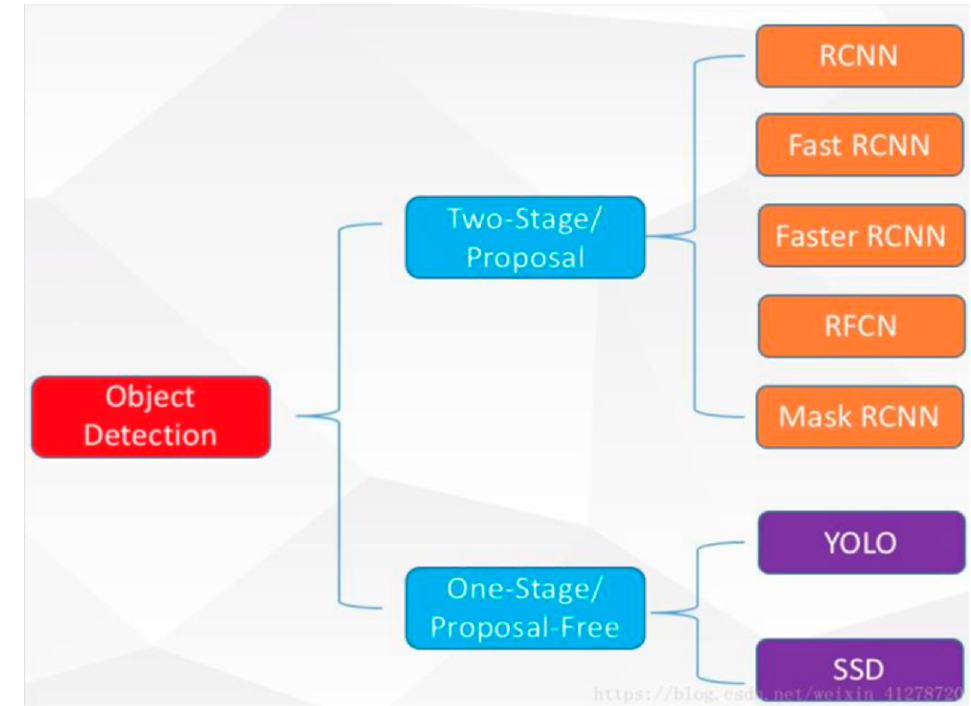
Figure 1. Object detection algorithms.